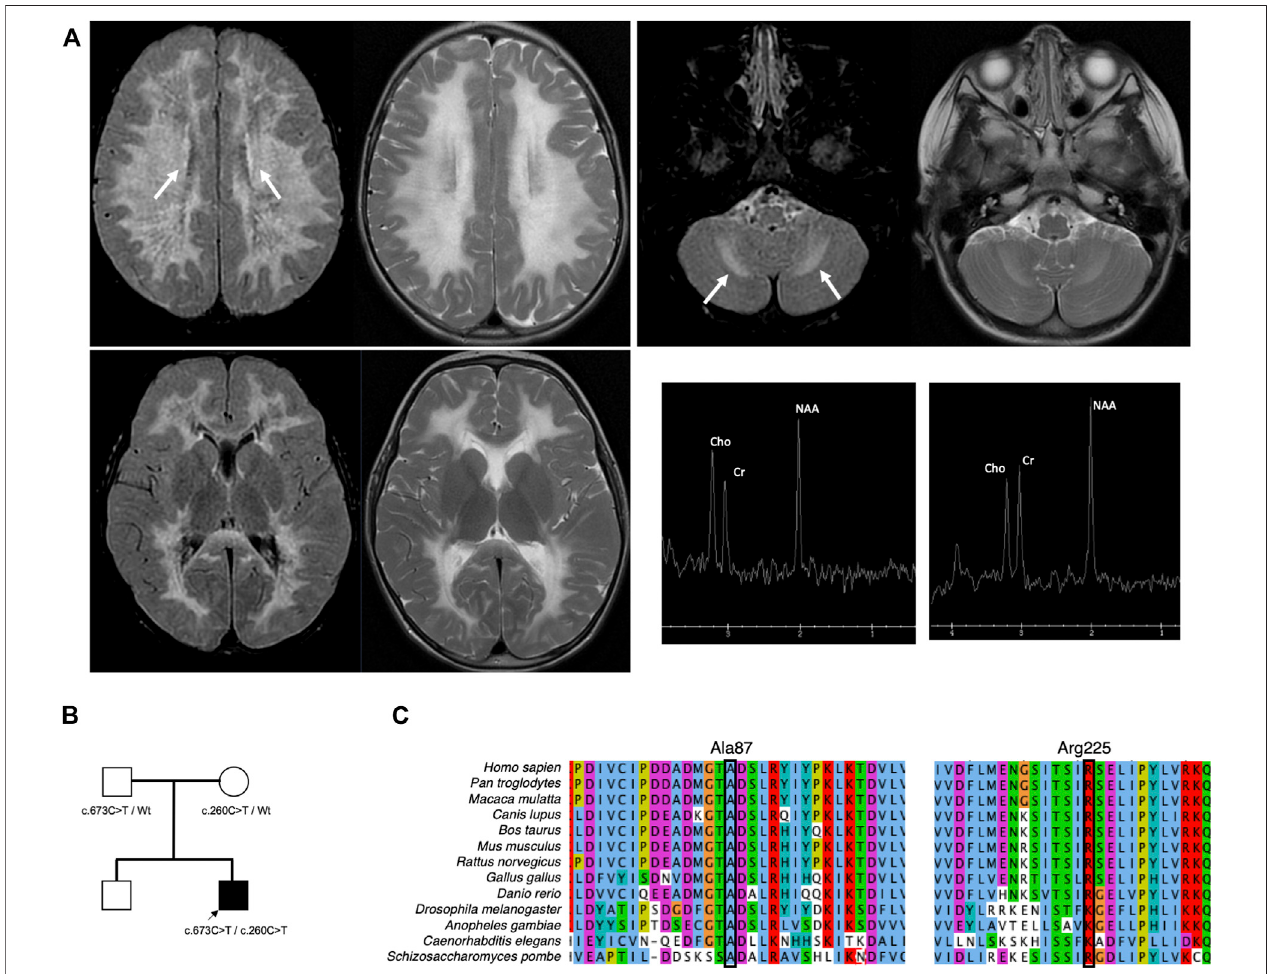
FIGURE 1 | Brain imaging and pedigree of the proband. (A) T2-weighted MRI of the brain performed at 2 years and 11 months shows diffuse bilateral hyperintensity with a symmetrical distribution involving the supratentorial (left upper) and the cerebellar white matter (right upper) while sparing the basal ganglia (left lower). Elevation of the choline peak was detected on MR spectroscopy from the centrum semiovale but not from the basal ganglia (right lower). The proband inherited biallelic EIF2B3 variants from both parents (B) . Both variants are highly conserved (C)